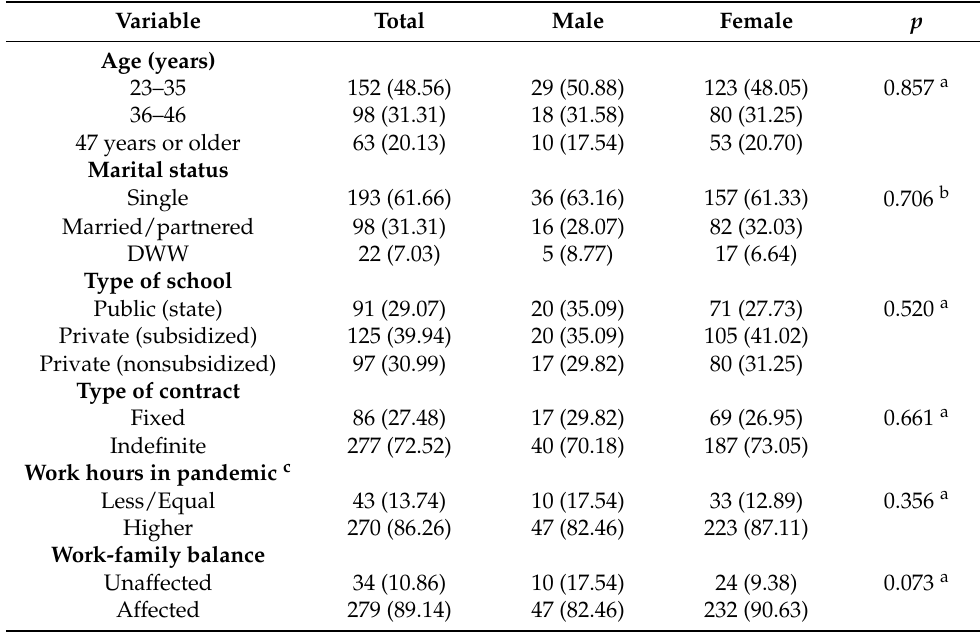
Table 1. Sociodemographic characteristics of the